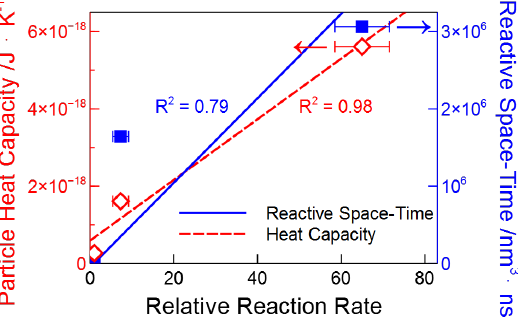
Figure 5. Reaction rate as compared to the heat capacity of a single particle and the reactive space-time, as well as linear least square fits to these